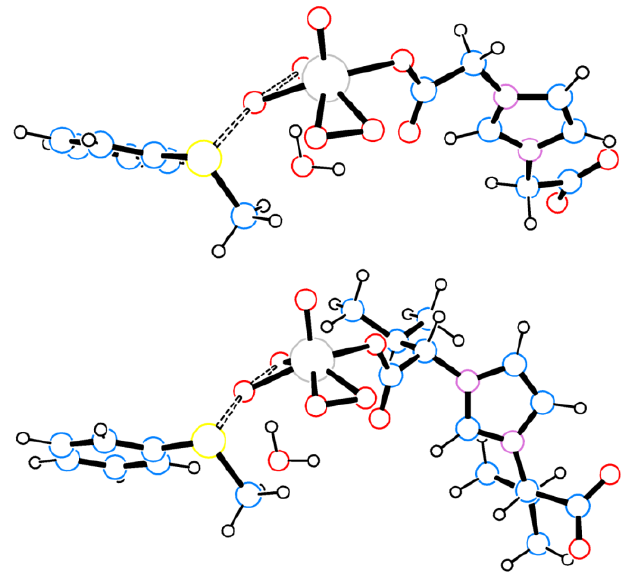
Figure 3. Calculated transition states for the oxido-transfer step from [Mo(O)(O 2 ) 2 (H 2 O)(κ 1 - O -L R )] − complexes to PhMeS (R = H, TS_a1 , top; and iPr, TS_c1 , bottom).